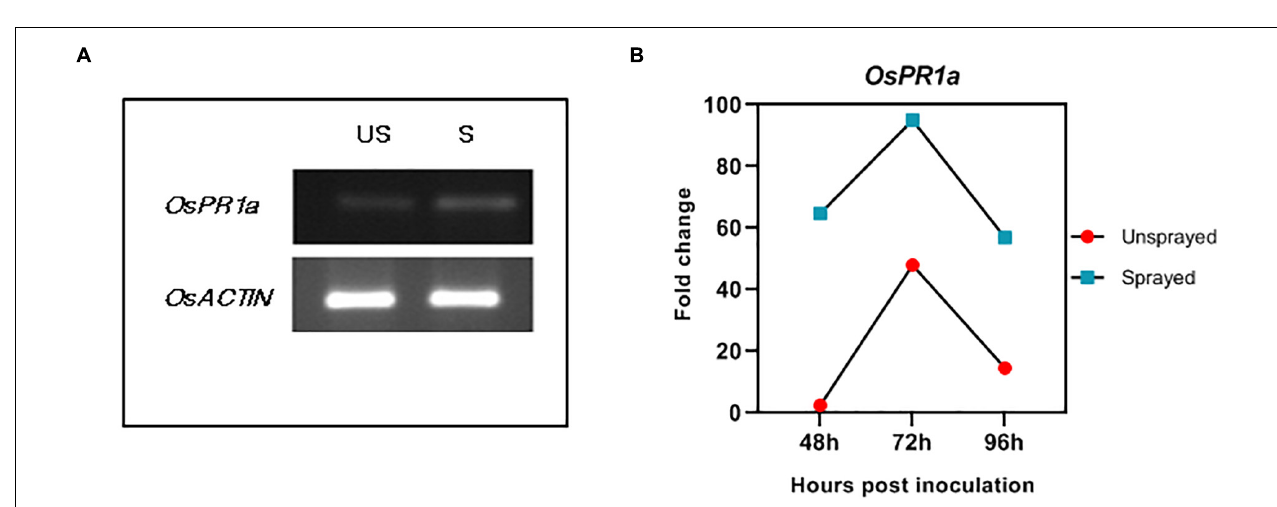
FIGURE 8 | Expression of OsPR1a . (A) Semi-quantitative Reverse transcriptase PCR for rice defense- related PR1a in ds DES1 -sprayed and unsprayed plants 72 hpi. (B) The relative fold change for OsPR1a expression in sprayed and unsprayed plants 48, 72, and 96 hpi, normalized against the house-keeping control OsACTIN. The reactions were set up in